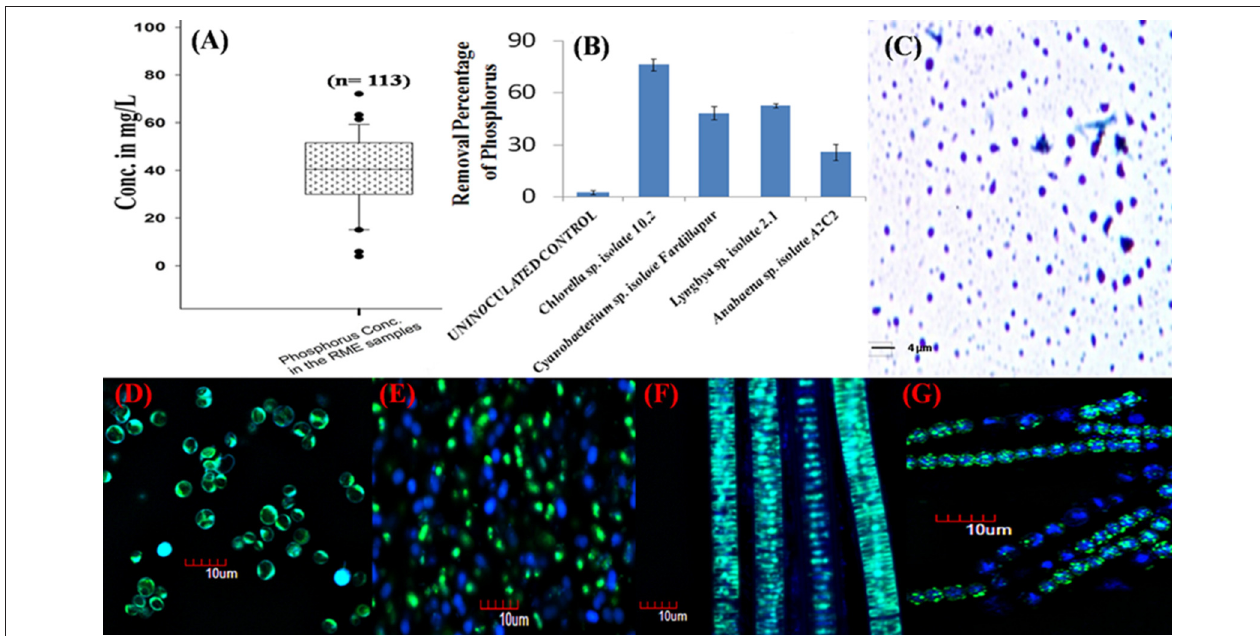
FIGURE 1 | Soluble phosphorus in parboiled rice mill effluent and its remediation by microalgae and cyanobacteria as polyphosphate accumulators. (A) Box plot showing the phosphorus concentration in the rice mill effluent samples collected from West Bengal, India. “n” is the number of rice mills from where the samples were collected. Solid line in the box represents median values. Box represents 25–75% percentiles; range bar represents 5 and 95% percentiles, and dots beyond these bars represent values outside the 95% confidence interval. (B) Percentage removal of phosphorus from a rice mill effluent sample (initial phosphorus concentration was 35mg/L) by different microalgae and cyanobacteria over a period of 21 days. All the bars on the graph represent the average data of 10 replicate experiments. Error bars were calculated on the basis of standard deviation of the data using the software Microsoft Excel. (C) Cell-free extract of polyphosphate granules stained with the Toluidine Blue dye as observed under bright field microscope. (D–G) DAPI staining of polyphosphate granules present in Chlorella sp. isolate 10.2 (Accession No. KJ654316), Cyanobacterium sp. isolate Fardillapur (Accession No. JX023443), Lyngbya sp. isolate 2.1 (Accession No. KF644563) and Anabaena sp. isolate A2C2 (Accession No. KF644564) observed under confocal microscope. The yellowish-green fluorescence indicates the presence of polyphosphate granules in the cells whereas the cells devoid of the granules emit blue